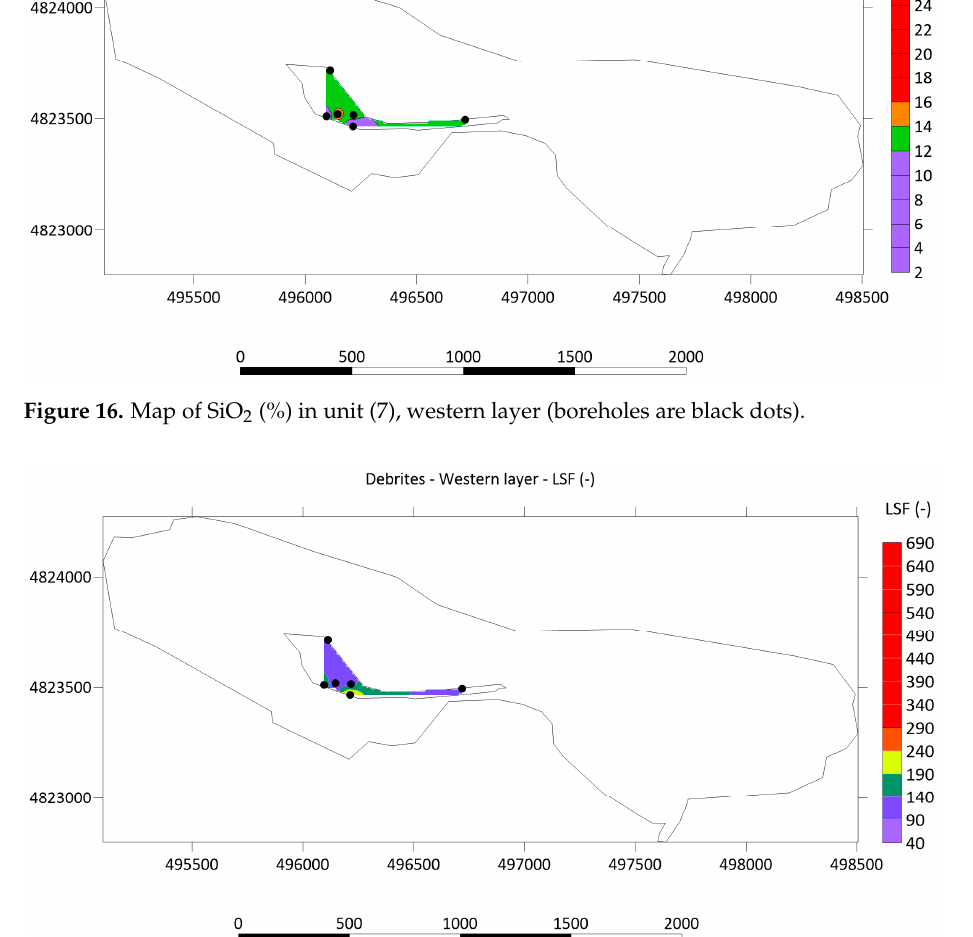
Figure 17. Map of LSF ( − ) in unit (7), western layer (boreholes are black dots).